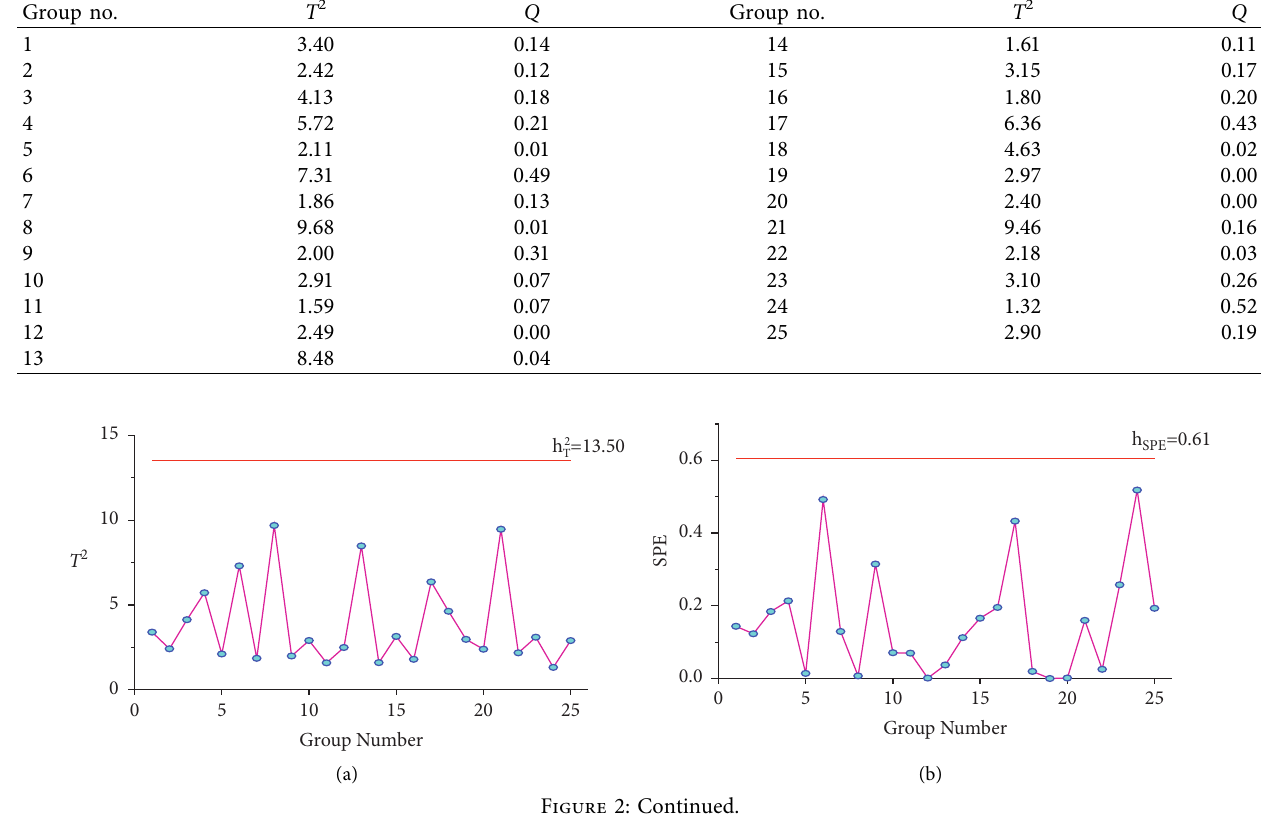
Table 2: Rated value of T 2 control chart and SPE control